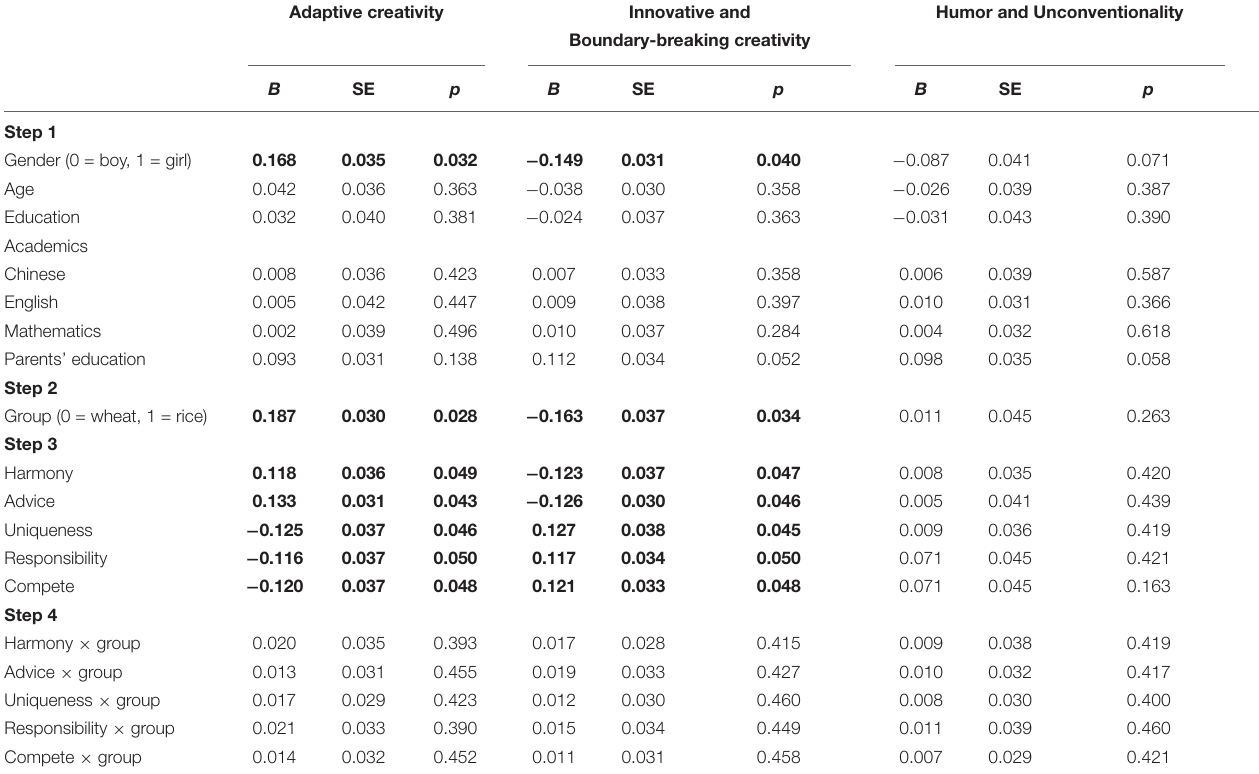
Bold indicates significant